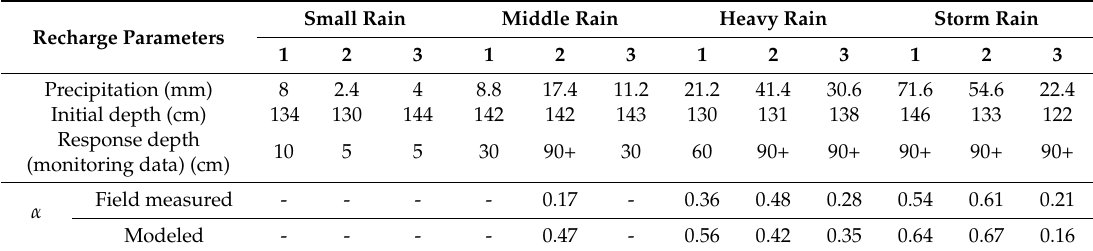
Table 5. Recharge coefficients of precipitation obtained by the model and field data. Small Rain Middle Rain Heavy Rain Storm Recharge Parameters